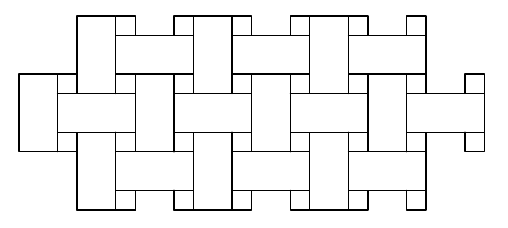
Fig. 56: Tiling with square and rectangle.